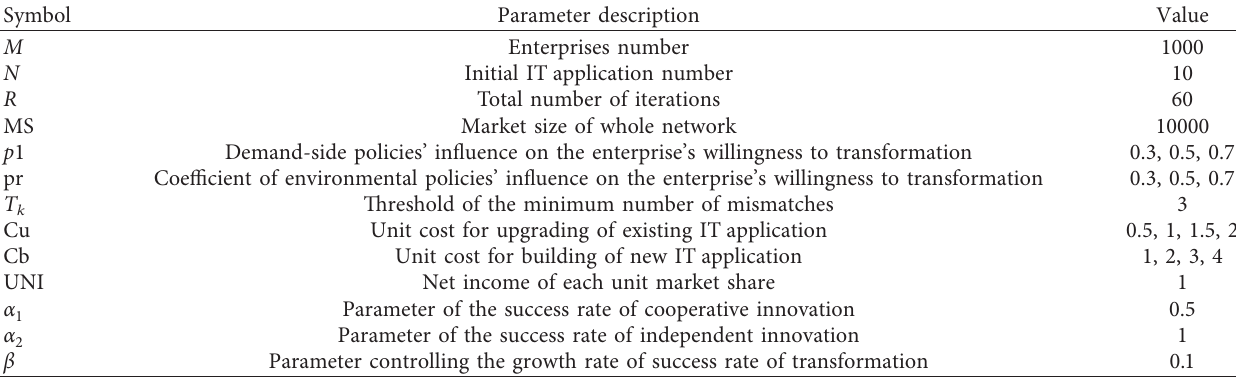
Table 1: Parameters involved in the model and their